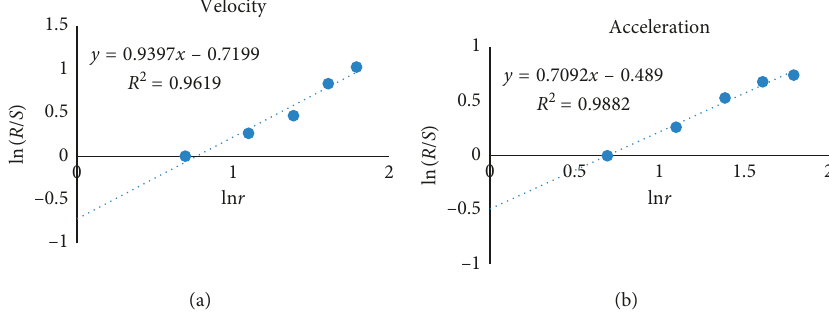
Figure 7: The last 6 data analyses results of R / S graph: (a) acceleration of R / S and (b) speed of R / S .